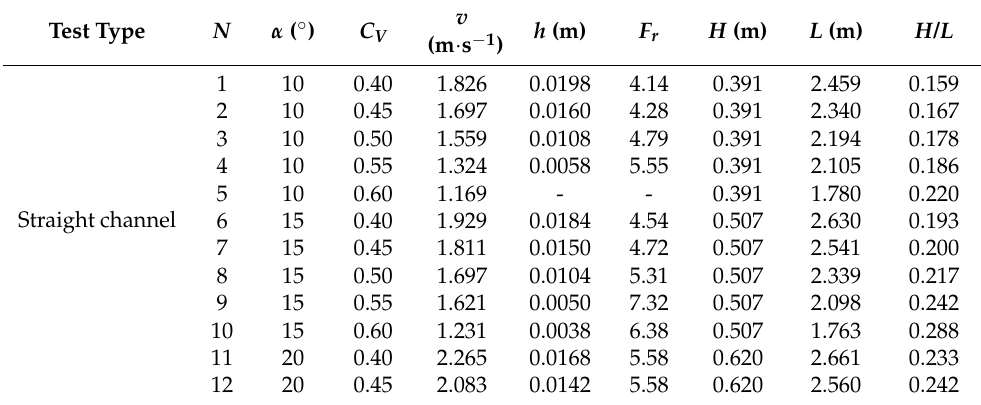
Table 6. Observed data from flume